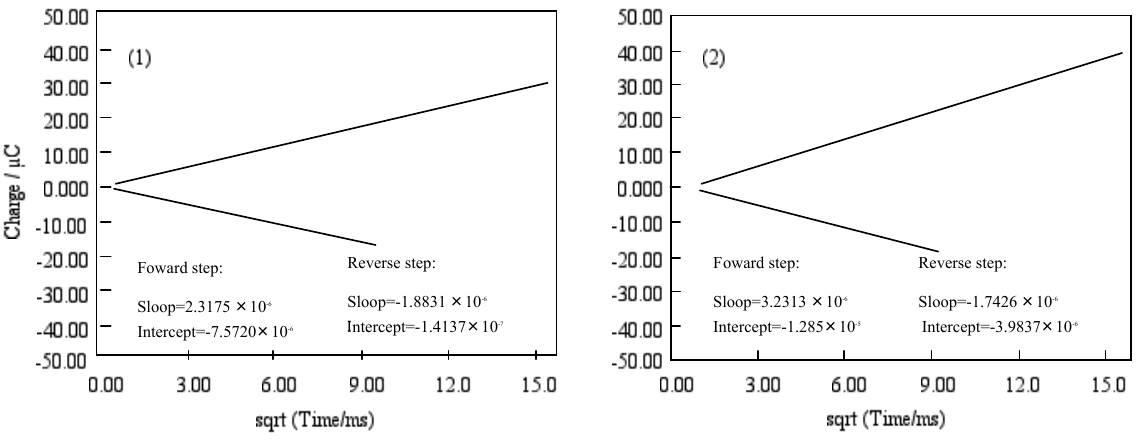
Figure 10. Anson plots of cobalt phthalocyanine tetrasulfonic acid (1) and cobalt phthalocyanine octacarboxylic acid